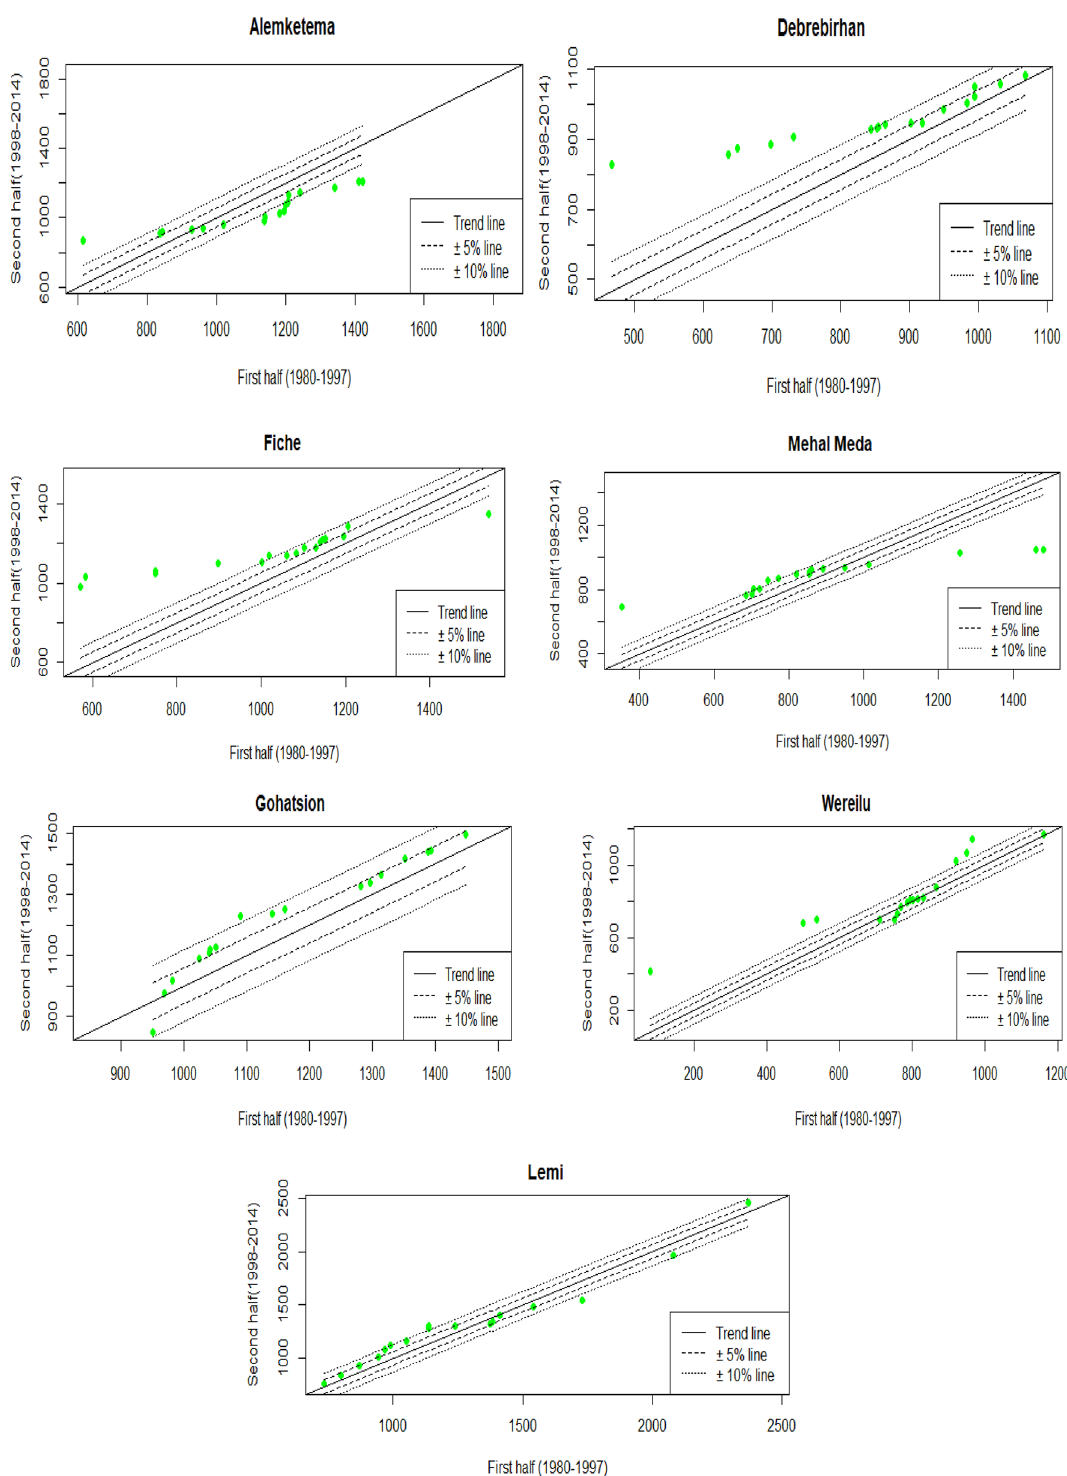
Fig. 4 Innovative trend analysis graph for precipitation: The path of red dots along the trend line is indicating the increasing /decreasing trend of precipitation between 1980 and